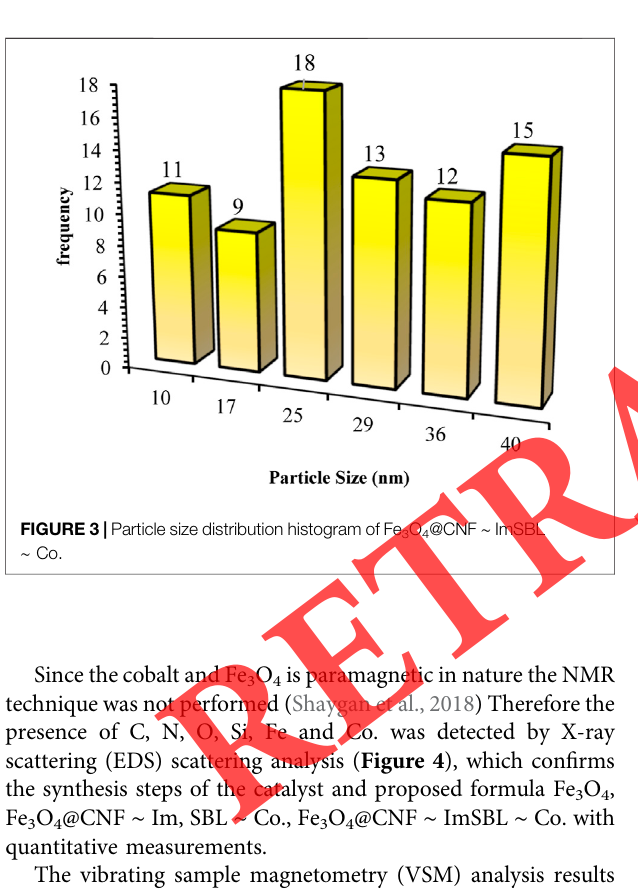
Frontiers in Chemistry |